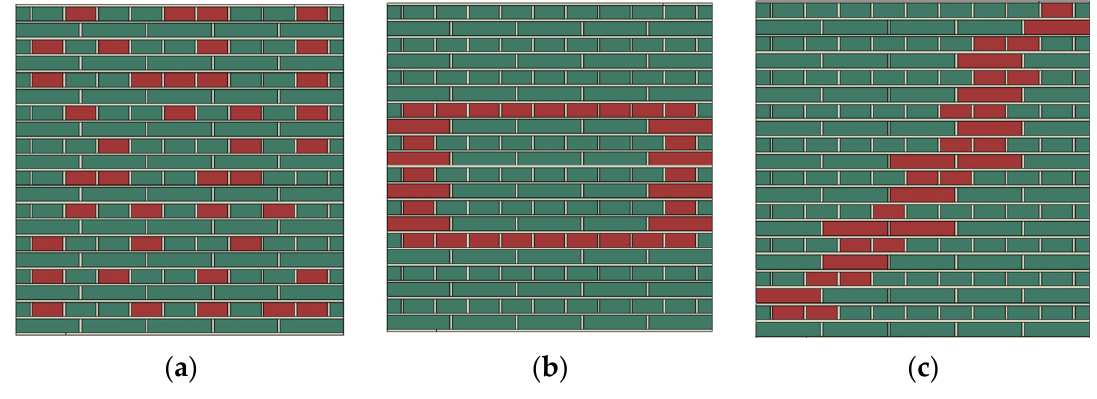
Figure 13. Weak-brick patterns: ( a ) R1; ( b ) R2; ( c ) R3.